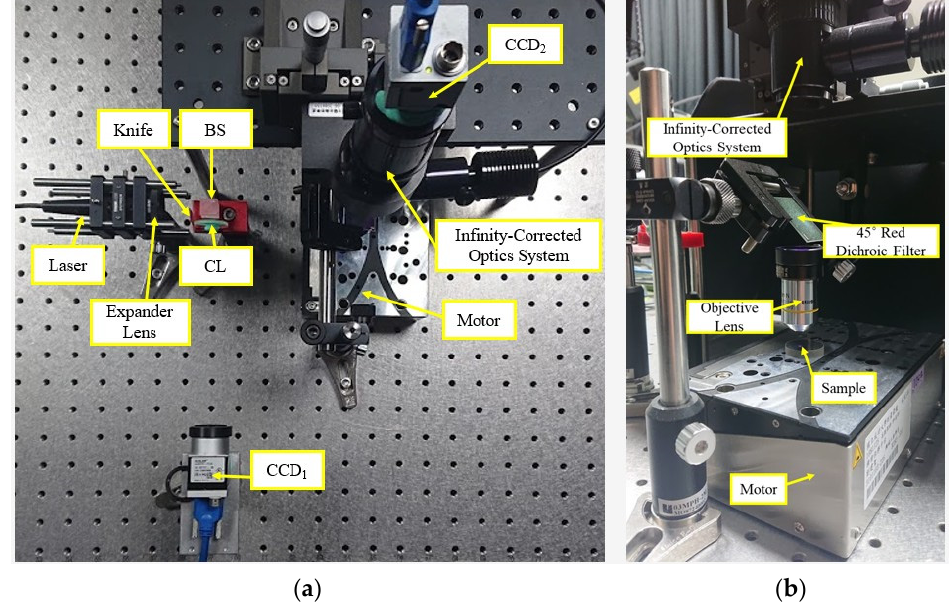
Figure 4. ( a ) Photograph of laboratory-built prototype; ( b ) infinity-corrected optics system